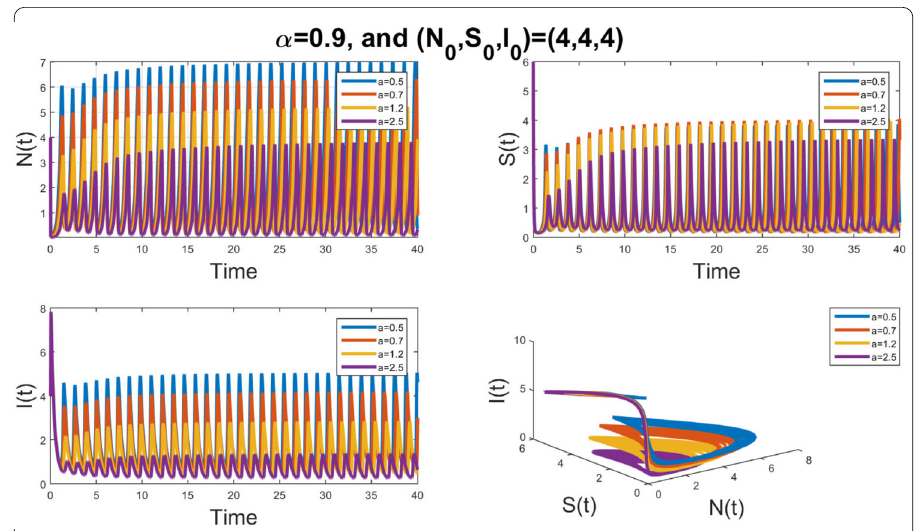
Figure 10 Influence of the hunting cooperation coefficient on the evolution of the species